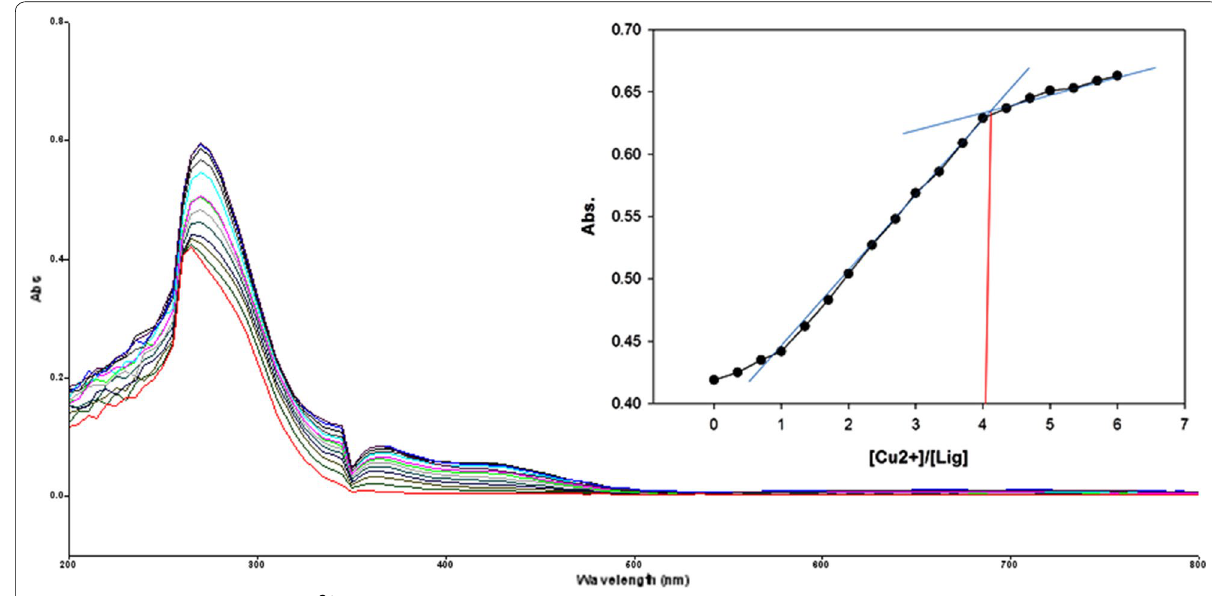
Fig. 11 Titration of isomer 1B vs Cu 2 + ( Inset Binding behavior